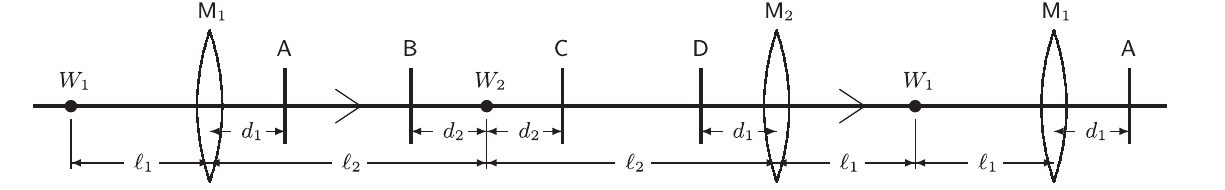
FIG. 6. A schematic of the optical cavity equivalent to that of Fig. 4(b), but unfolded to straighten the optical axis. A , B , C , and D ( W ) indicate the position of the radiation waist inside (outside) the undulator. label the crystal positions, while W 1 2